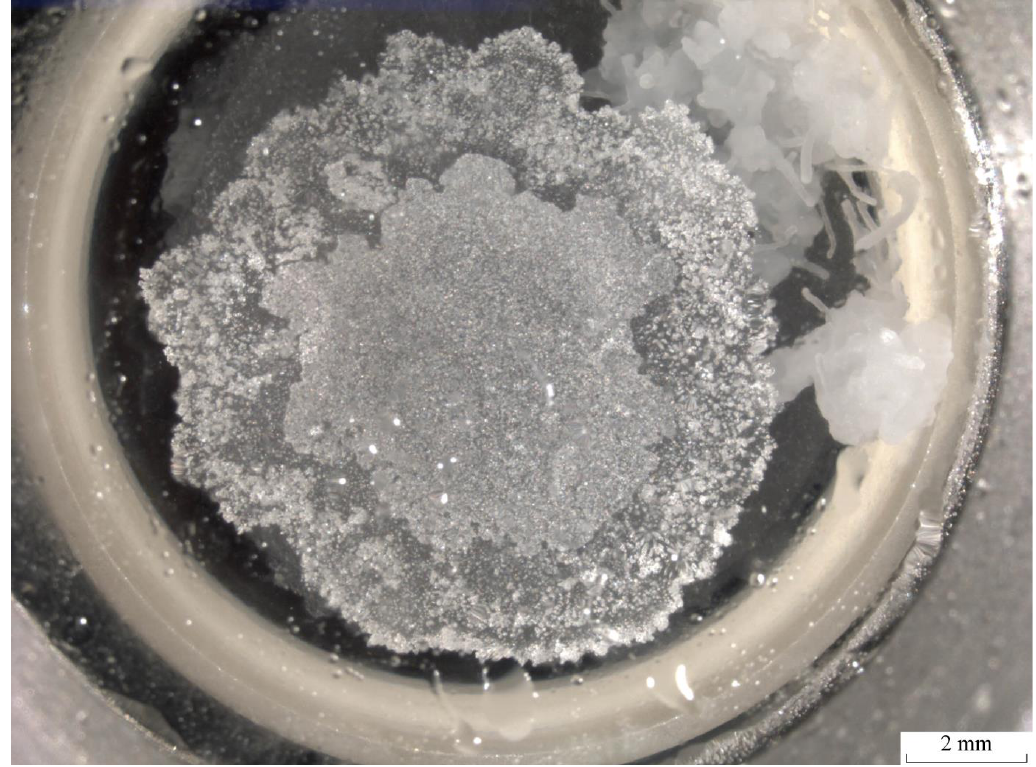
Figure 10. A mixed sample of several morphological types of xenon hydrate (dense fine-grained, large filamentous and massive); observed at +9.0 °C, 8 atm.